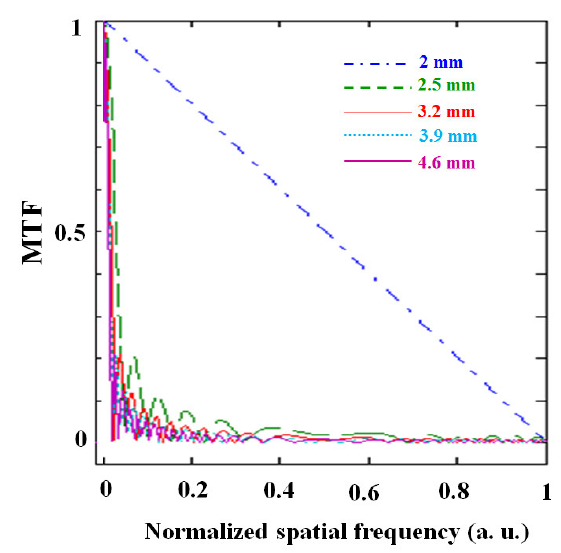
Figure 2. Calculated modulation transfer function (MTF) curves of initial optical endoscope (from Equation (9)) varied with object distances. The blue dotted-dashed line, green dashed line, red thin line, blue dotted line and purple thick line represent the object distances of 2 mm, 2.5 mm, 3.2 mm, 3.9 mm and 4.6 mm. The normalization factor, also referred as maximum spatial frequency, depends on the diameter of Airy disk of the optical system, which can be defined as D a to the parameters of diameter of entrance pupil D a = 0.836 mm, objective distance d o = 2 mm and λ = 0.586 µ m, the calculated normalization factor is 146 lp/mm.